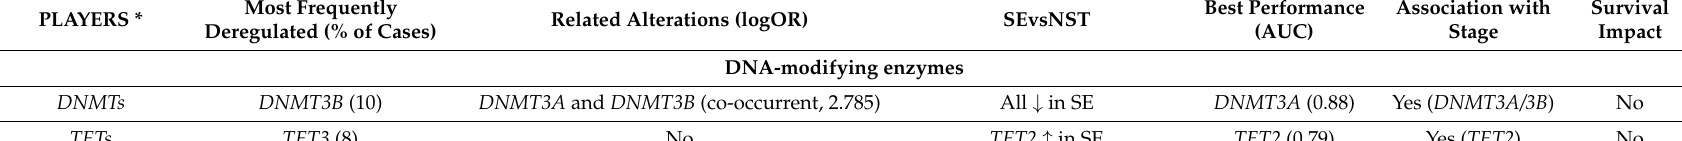
Table 2. Summary of most relevant DNA/histone-modifying enzymes and chromatin remodeling complexes involved in testicular germ cell tumors according to The Cancer Genome Atlas (TCGA) database